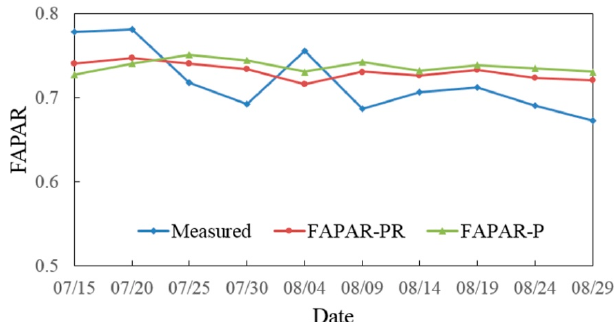
Figure 7. A comparison of the measured FAPAR and the model FAPAR calculated using the FAPAR model based on recollision probability (FAPAR-P) and rugged terrains (FAPAR-PR).